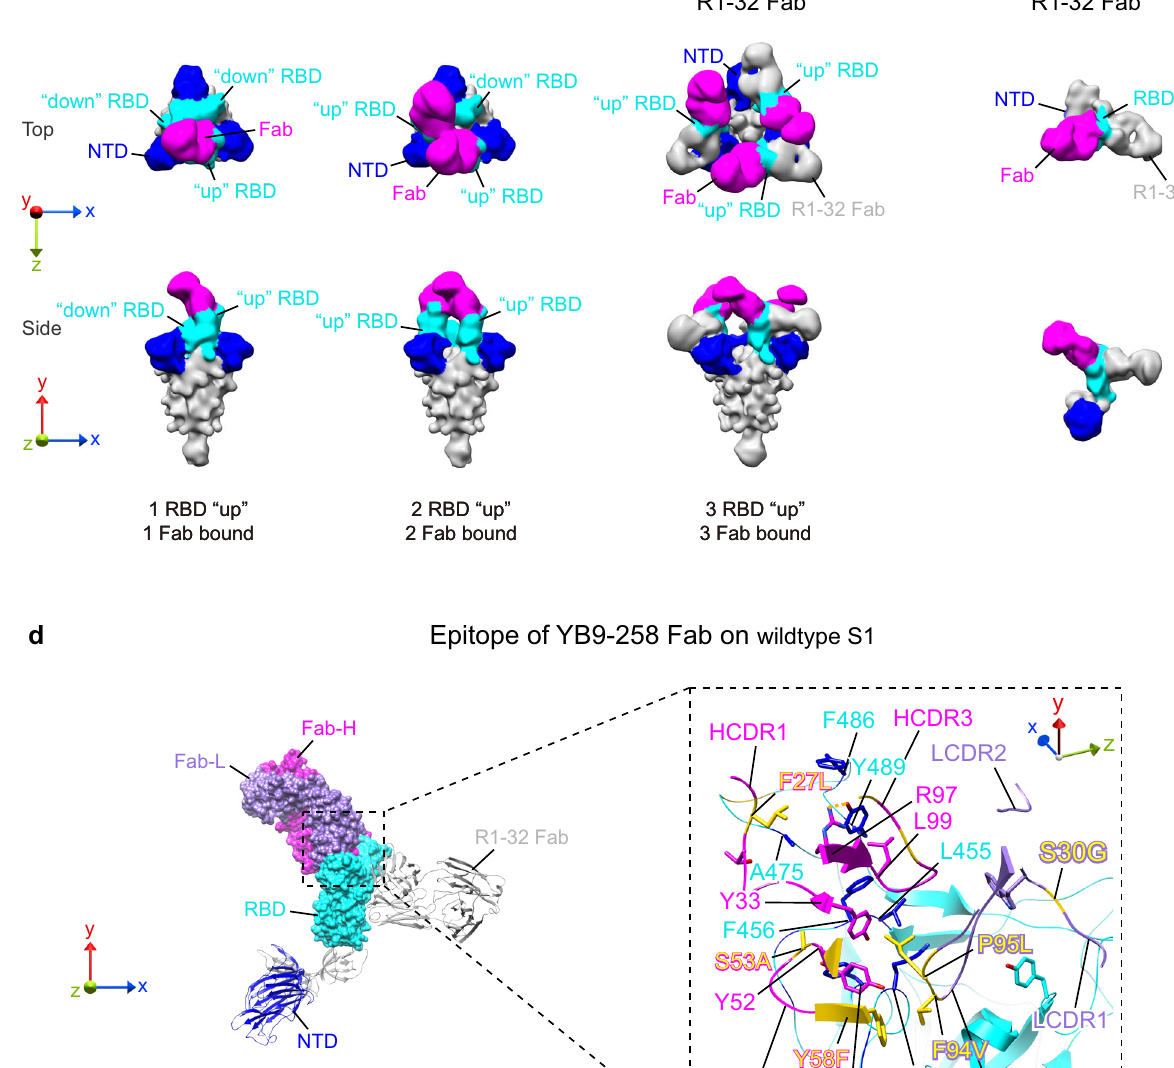
RBD of wildtype spike. CDR loops are indicated, selected interacting residues between RBD and antibody are shown and indicated. Somatically hypermutated residuesarehighlightedinyellowandsidechainsoftheonesinvolvedininteraction are shown with changes indicated (also see Supplementary Fig. 7). Dashed lines indicate hydrogen bonds. Highly buried RBD residues (BSA>30Å) are colored